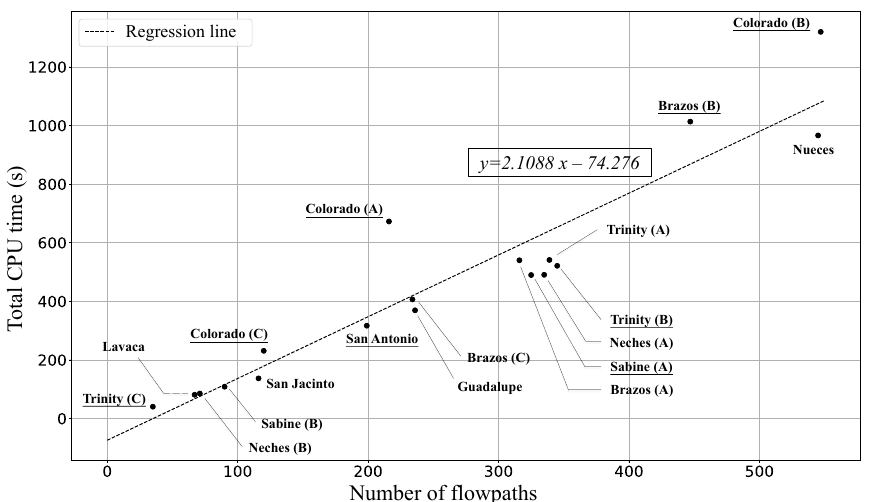
Figure 13. The relationship between SSA method CPU time and flowpath number of river networks. Networks with problematic channel segments are underlined.